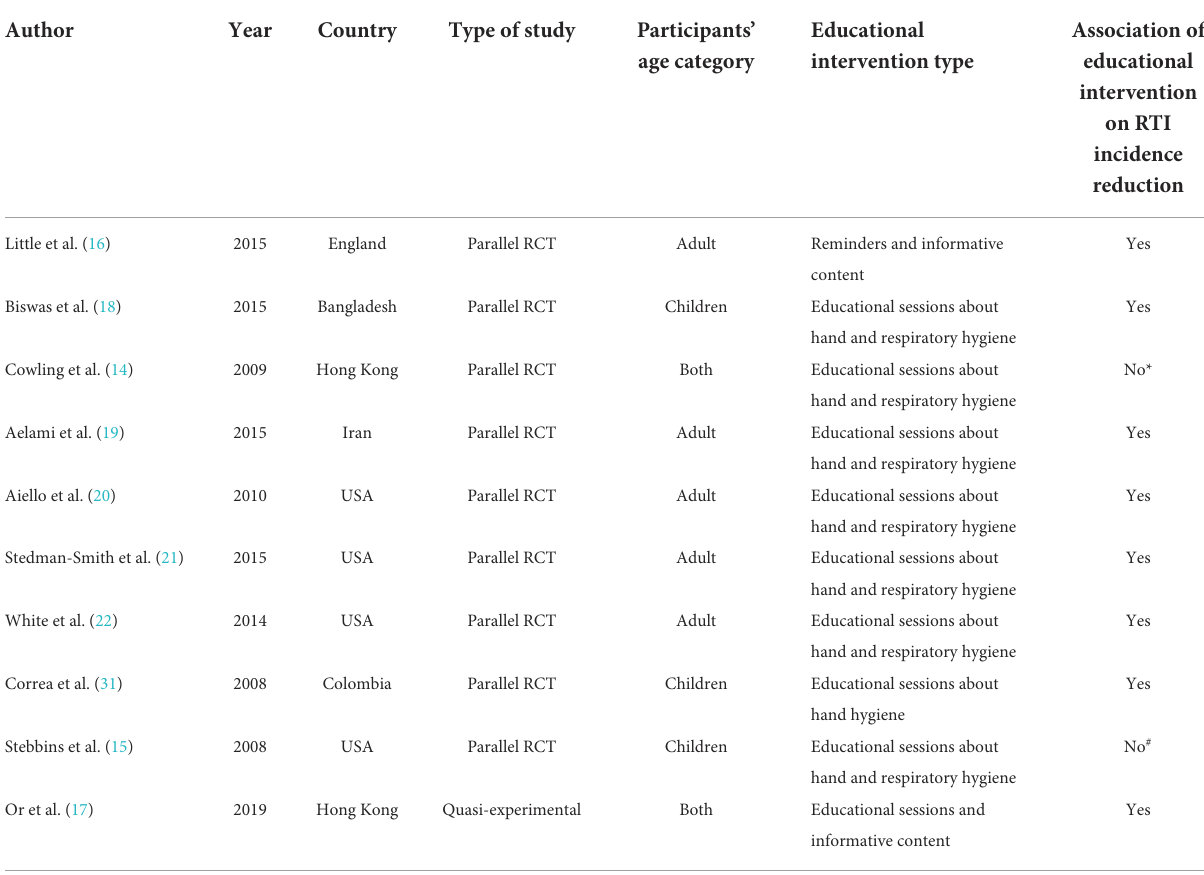
TABLE 1 The association of educational interventions on RTI